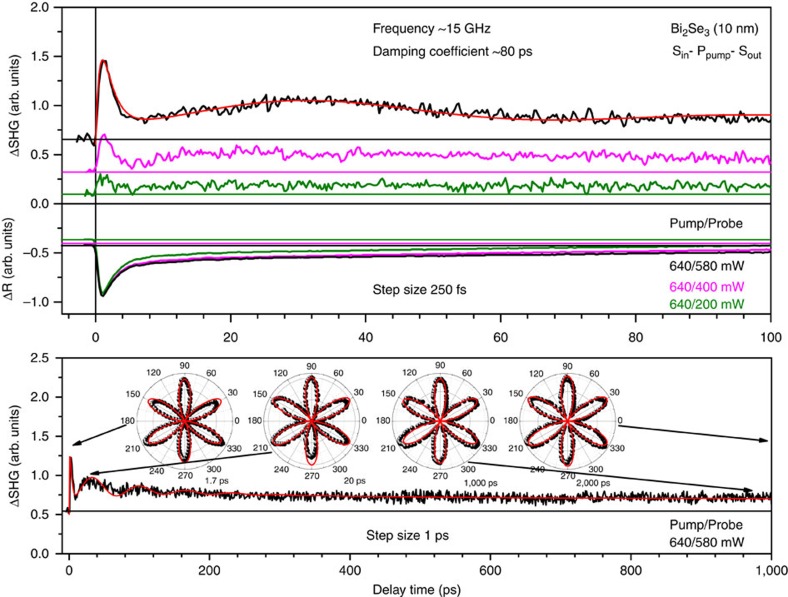
TR and TSHG traces for the 10 nm thick Bi2Se3 film.Upper panel shows TR and TSHG traces for the 10 nm Bi2Se3 film simultaneously measured with 250 fs step-size in the Sin−Ppump−Sout polarization geometry at different pump/probe powers as indicated by the corresponding colours. The TSHG section also indicates the frequency and damping coefficient of the oscillatory part of the TSHG trace. Lower panel shows the corresponding longer delay-time range TSHG trace measured with 1 ps step-size at 640/580 mW pump/probe powers. The normalized TSHGRA patterns measured at the fixed pump-to-probe delay times as indicated by arrows are shown in the corresponding insets. The red curves in both panels present the best fit to the data.